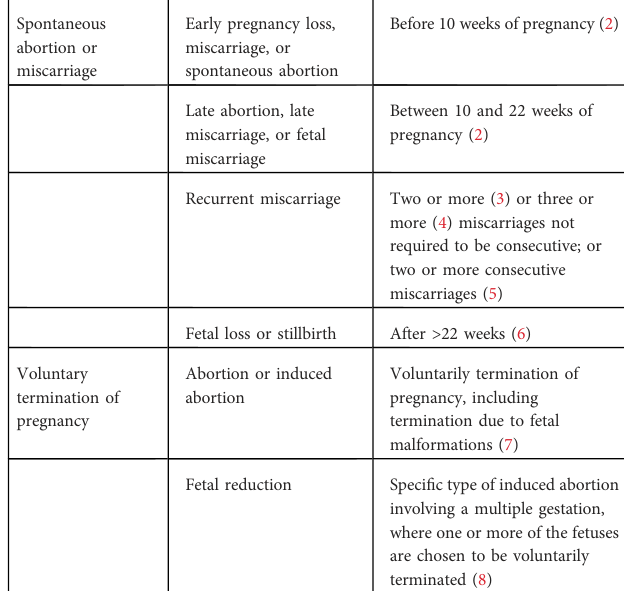
TABLE 1 Classi fi cation of pregnancy